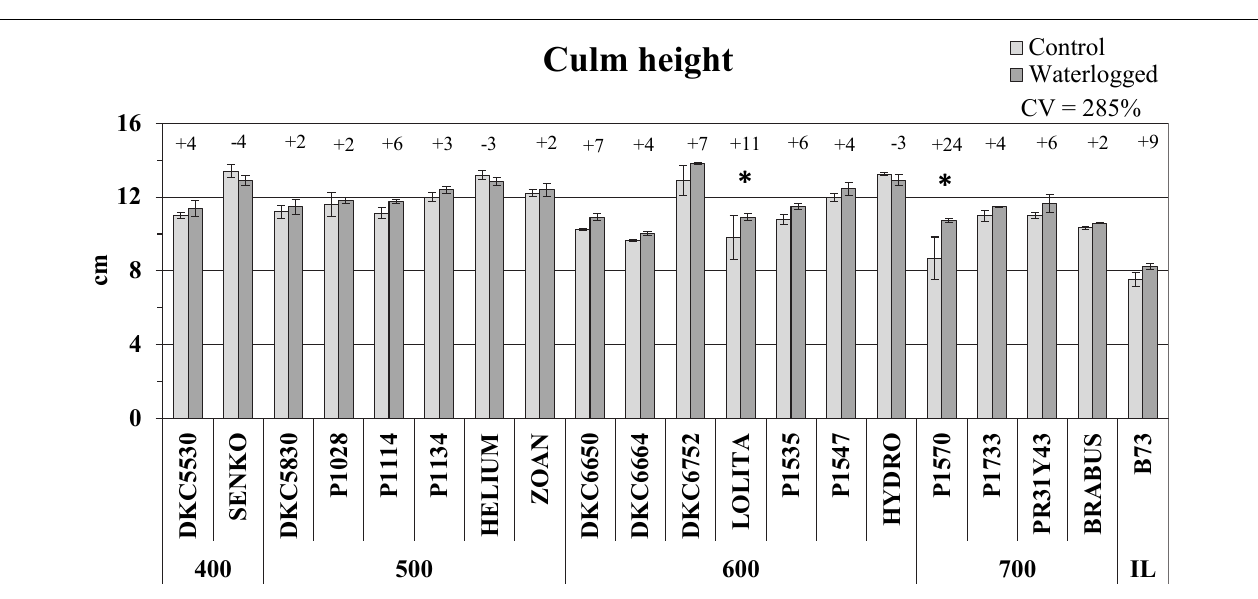
FIGURE 1 | SPAD readings (average SPAD units ± SE; n = 3) from control and waterlogged plants of commercial hybrids and the inbred line B73 at 17 days after sowing (DAS), grouped according to FAO class of maturity (from 400 to 700). Numbers above histograms indicate the percentage variation between waterlogged plants and controls for each hybrid, with asterisks indicating significance ( P ≤ 0.05).